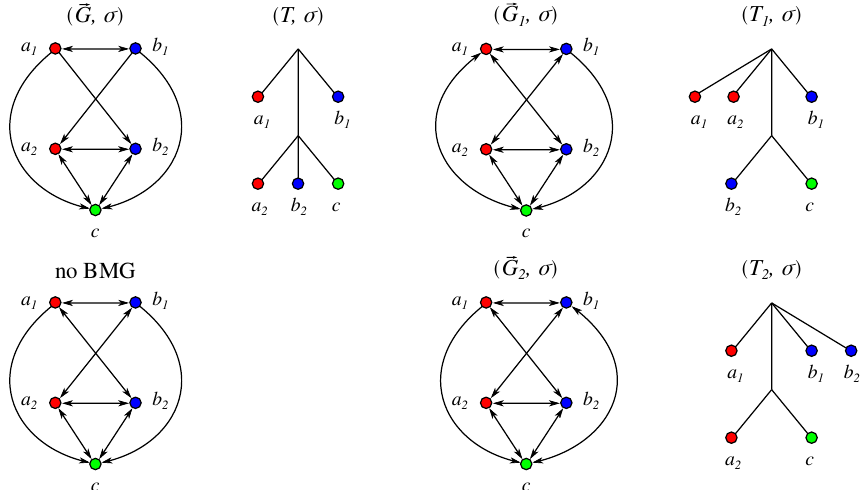
Figure 2. Example for 3-BMG CBEG with the 3-BMG ( G , σ ) (explained by the LRT ( T , σ ) ) as input that has no unique optimal solution. Insertion of the missing arcs ( a 2 , b 1 ) and ( b 2 , a 1 ) produces a digraph that is not a BMG. At least one of the arcs ( c , a 1 ) or ( c , b 1 ) has to be inserted additionally to obtain the beBMGs ( G 1 , σ ) and ( G 2 , σ ) (shown with their LRTs ( T 1 , σ ) and ( T 2 , σ ) ),